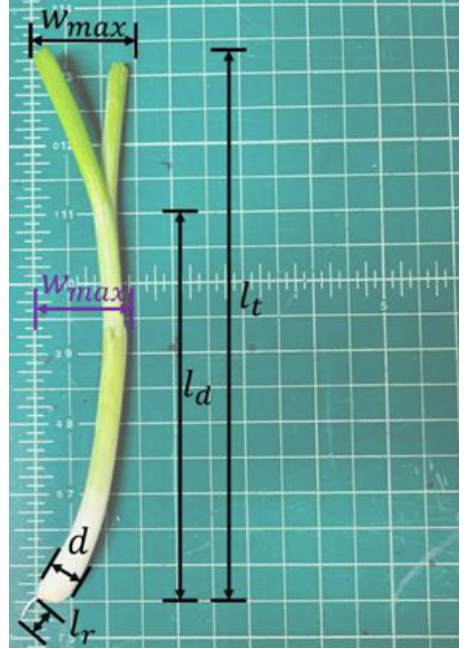
Figure 13. Measurements used to characterize the scallions. The parameters are: 𝑤 𝑚𝑎𝑥 is the maxi- mum width of the onion which typically occurred in either of the two places shown, 𝑙 𝑑 is the length from the onion bulb to the point where the stalk diverges, 𝑙 𝑟 is the length of the roots, 𝑑 is the bulb diameter, and 𝑙 𝑡 is the total length of the onion.